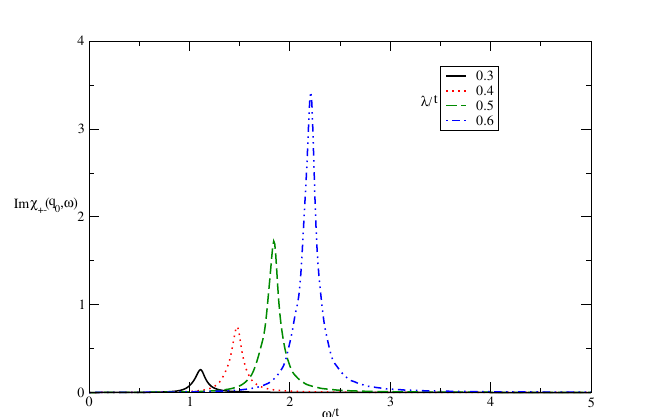
( q 0 , ω) of undoped +−